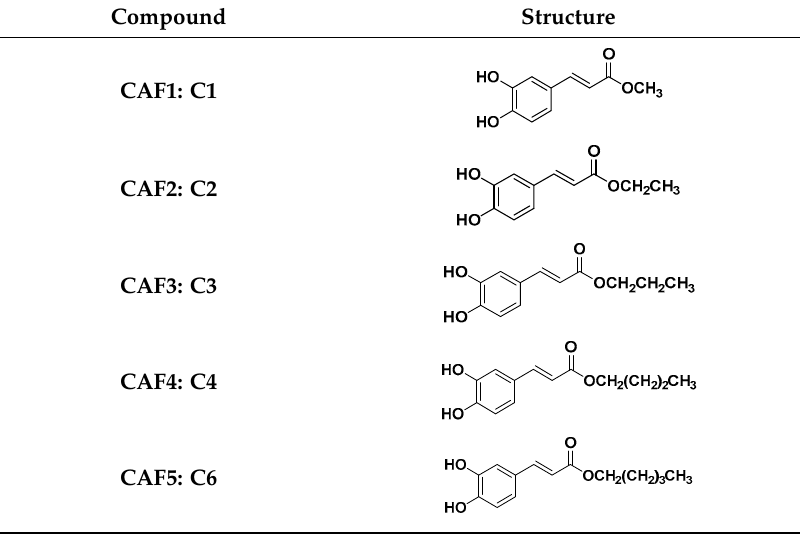
Table 1. Chemical structures of caffeic acid ester derivatives used in this study.